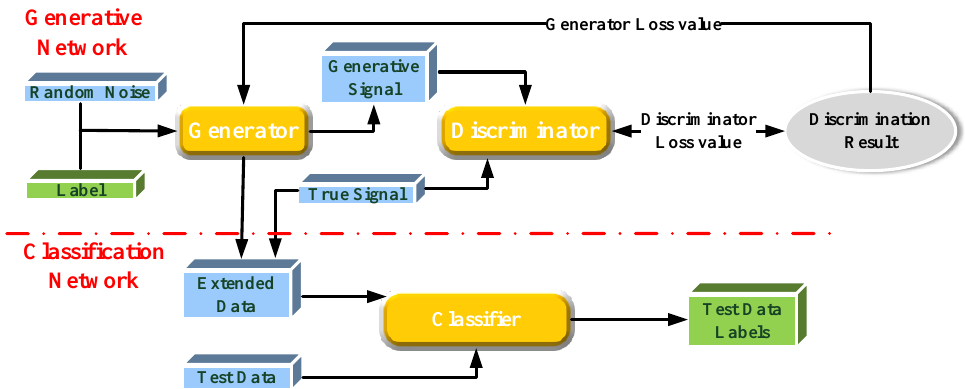
Figure 1. Fault Diagnosis Model of the Main Bearing of Wind Turbine.